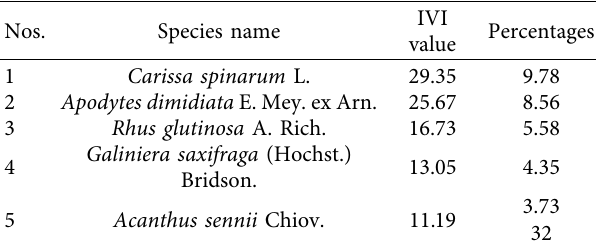
Table 7: IVI value of woody plant species in Jib Godo Natural